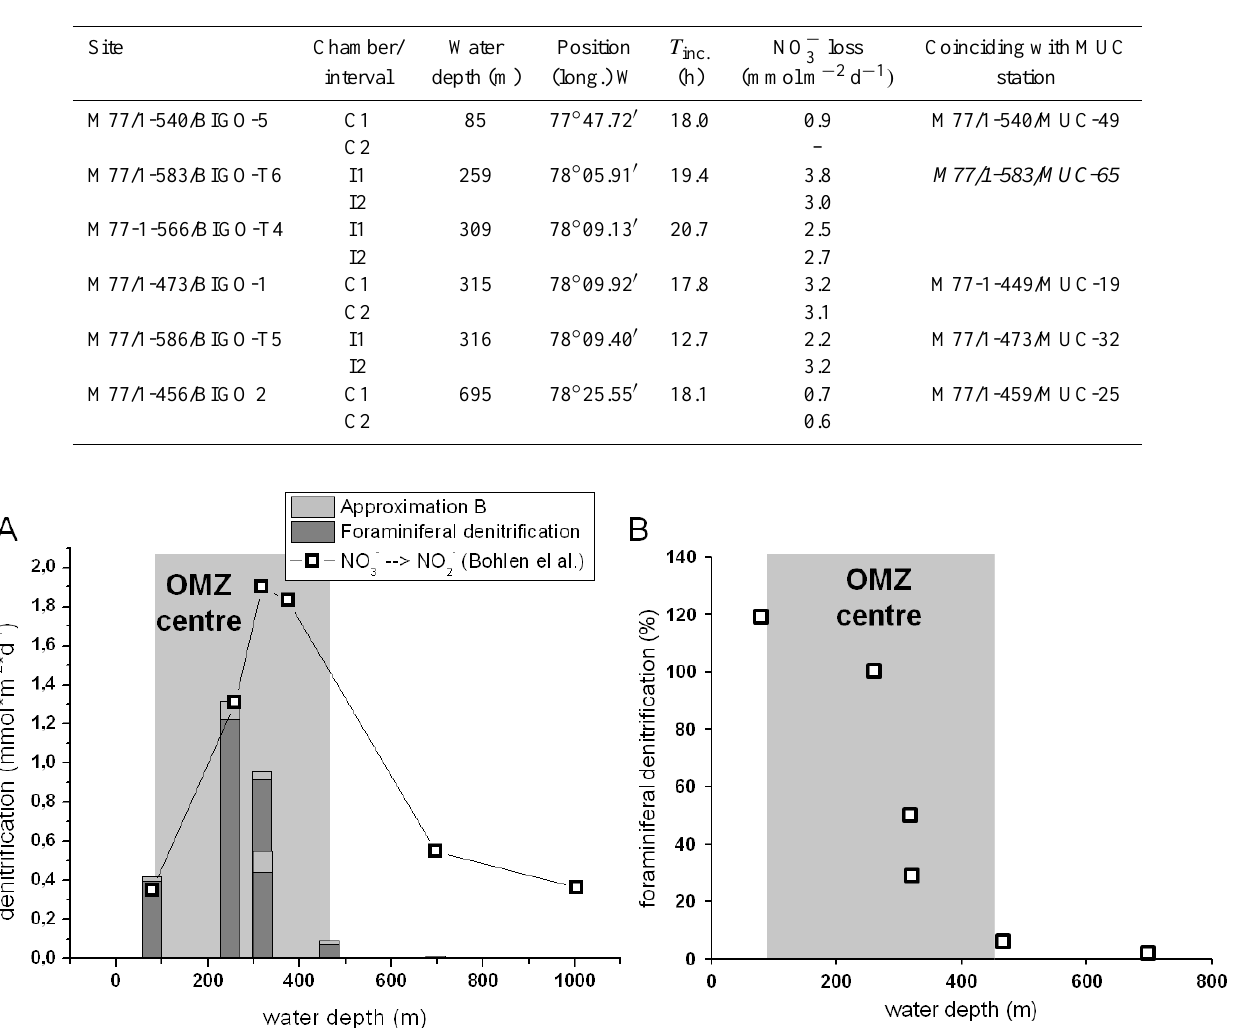
to NO − (Bohlen et al., 2011), 3 2 loss due to 3